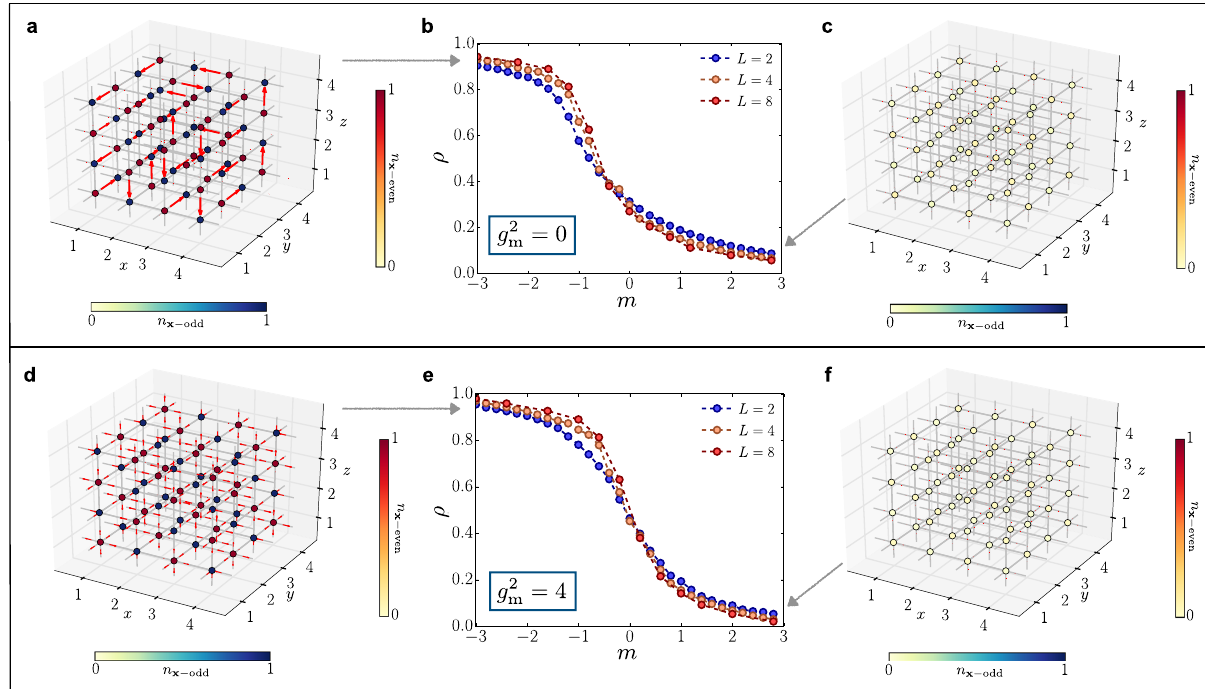
¼ 0. b Particle m ¼ 8 = g 2 ¼ 4. m e